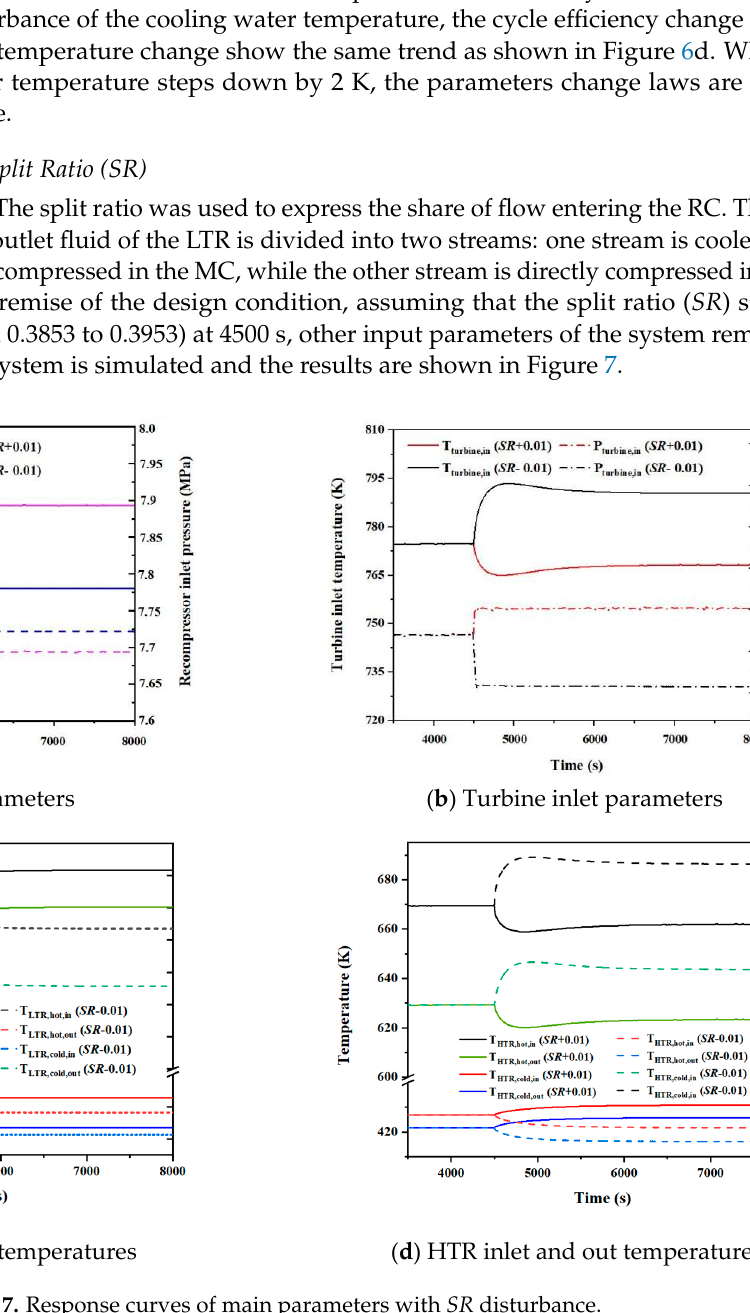
( d ) Efficiency Figure 6. Response curves of main parameters with cooling water temperature disturbance. 3.2. Split Ratio (SR)